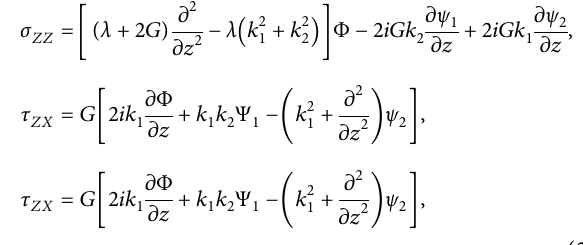
Figure 5. Rotary jet grouting piles were used to reinforce this section of subgrade. The distance between the rotary jet grouting piles was 2 m, arranged